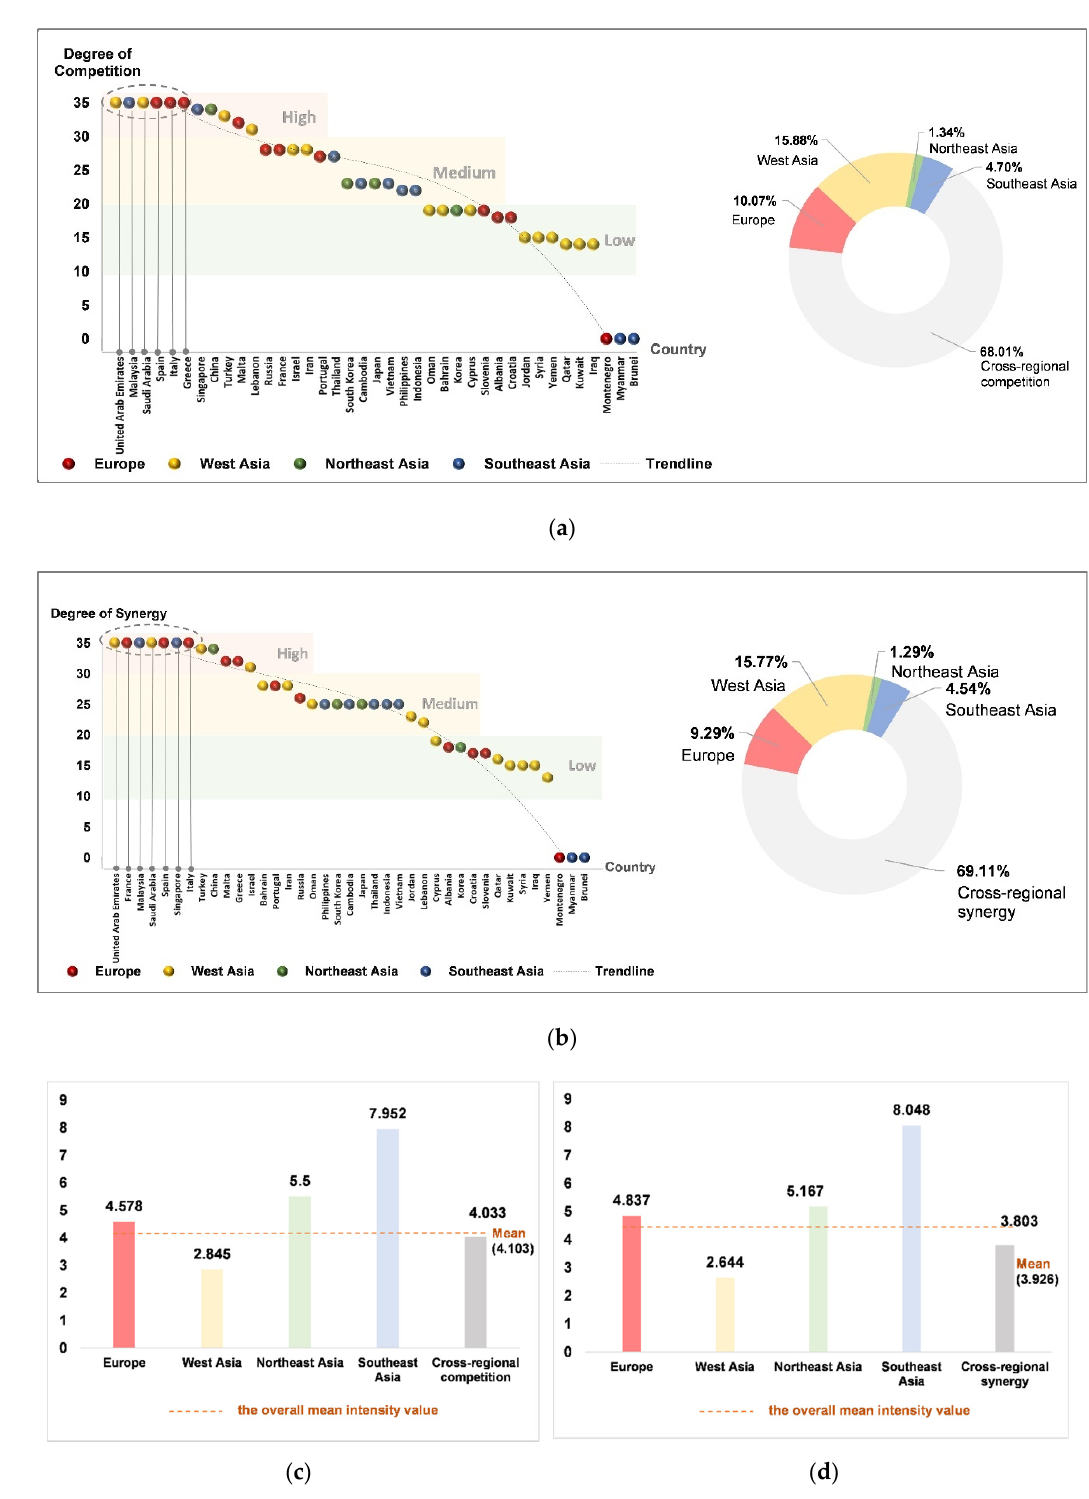
Figure 9. Dominant regional traffic relations quantification: ( a ) Degree distribution and percentage of competition; ( b ) Degree distribution and percentage of synergy; ( c ) Competition intensity; ( d ) Synergy intensity.